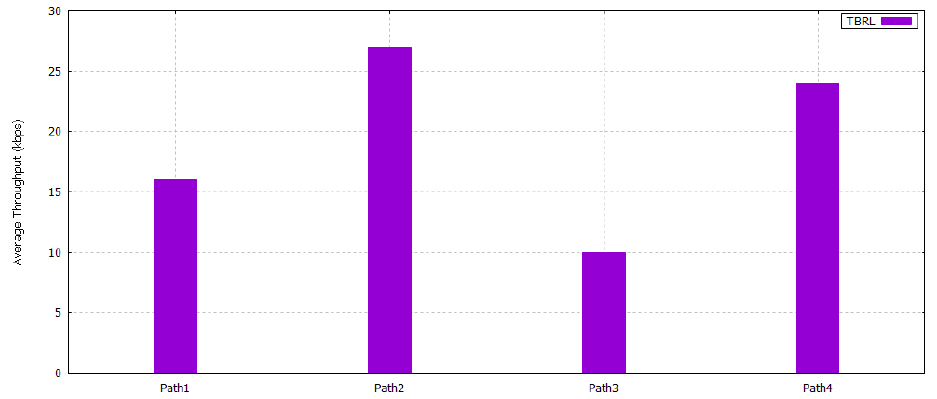
Figure 10. Throughput among Different Paths in TBRL.